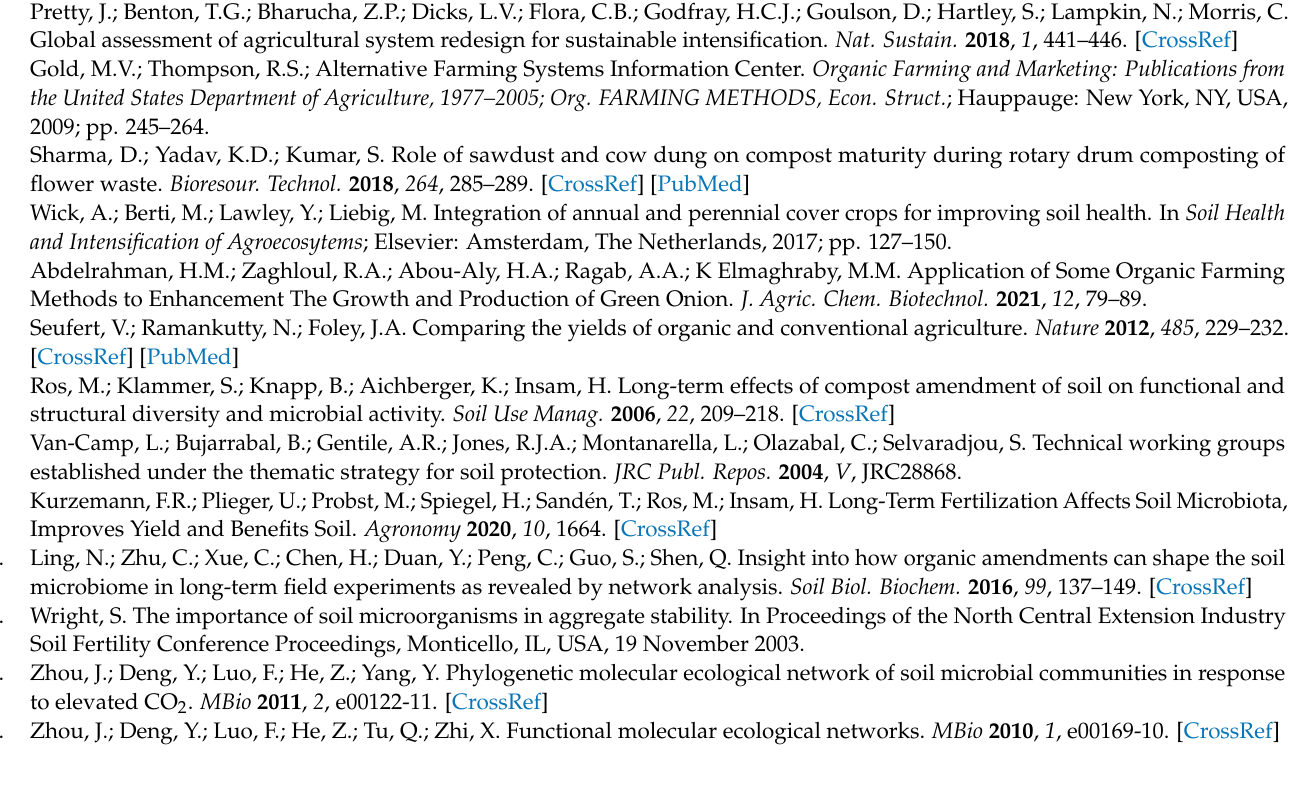
Table S5: Predicted functions of the bacterial communities found in the three cropping systems (relative abundances); Table S6: Mantel analysis of relationships between bacterial community and soil properties and N cycling